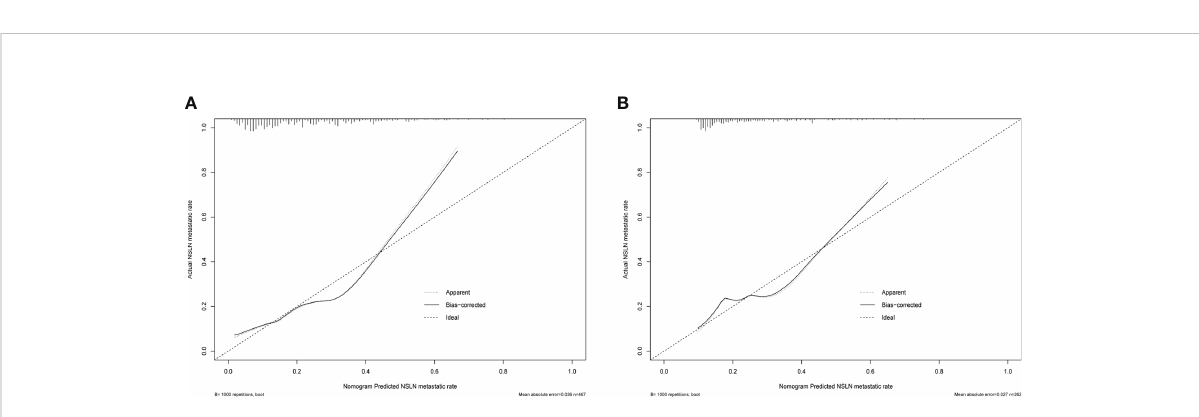
FIGURE 5 The predictive performance of the nomogram in estimating the risk of NSLN metastasis veri fi ed by the calibration curve in the training cohort (A) and validation cohort (B) . NSLN, non-sentinel lymph node.